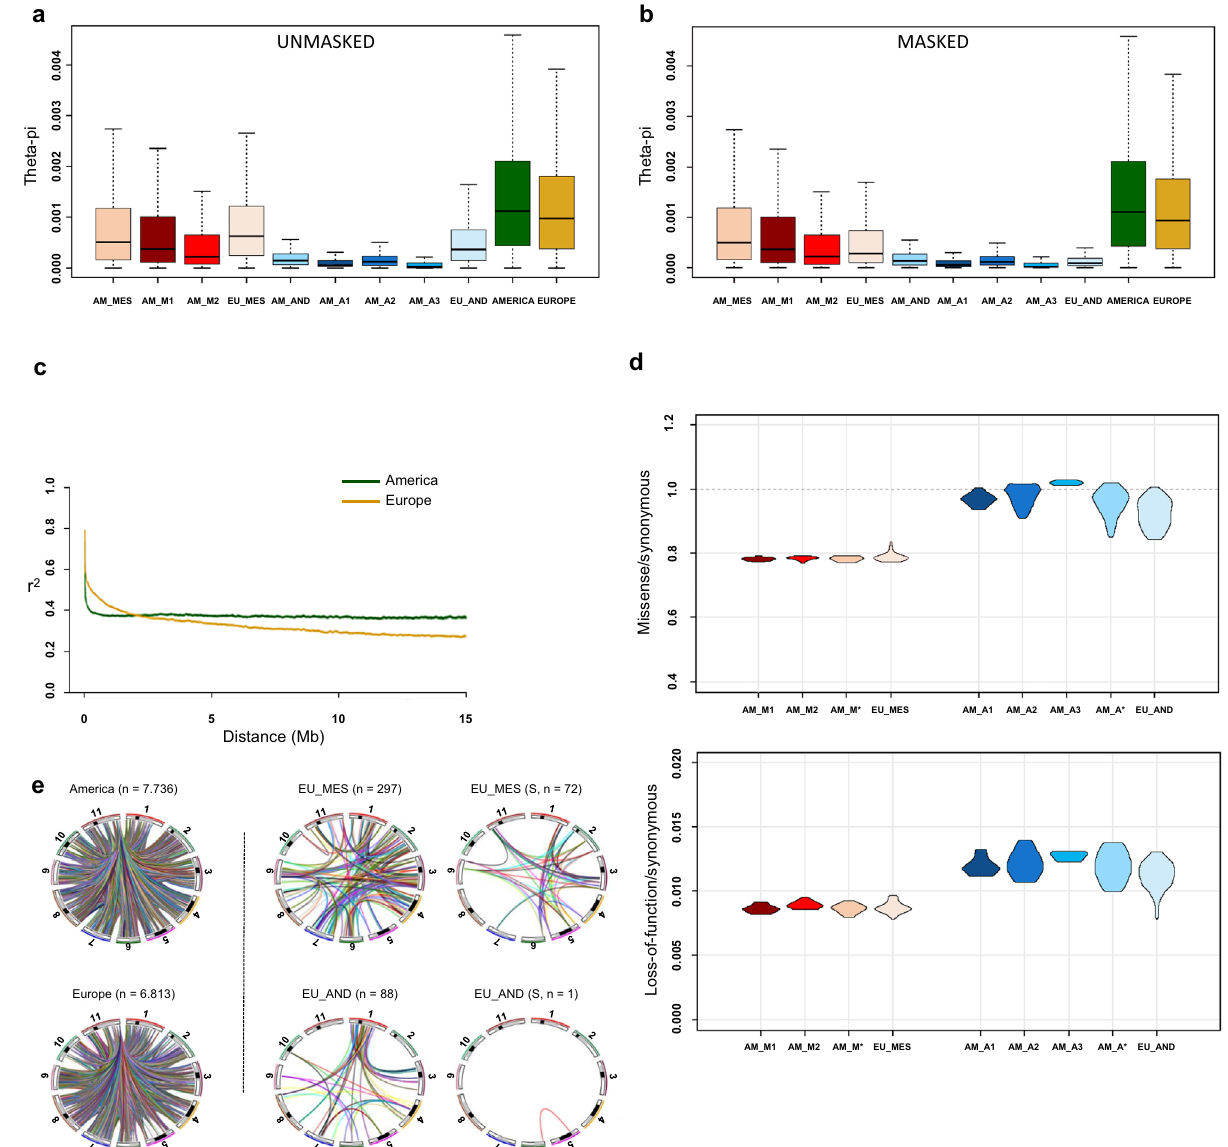
Fig.4|Boxplotsof θπ averagedover100kbnon-overlappingslidingwindows, linkage disequilibrium decay and inter-chromosomal linkage disequilibrium andgeneticload.a Geneticdiversitycomputedusingwholechromosomesandthe unmasked dataset. b Genetic diversity computed after the admixture masking process using whole chromosomes and linkage disequilibrium (LD) decay according to the physical distance. c Comparative LD decay in the American and Europeanaccessions. d Genome-widemeasureofgeneticloadintheAmericanand European accessions. The ratios are shown for missense (up) and loss-of-function